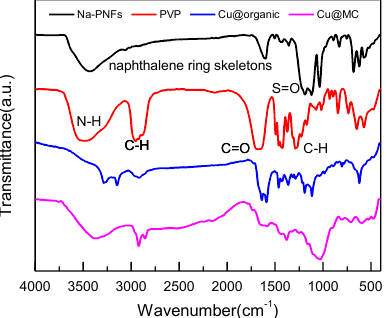
Figure 6. FT-IR spectra of Na-PNFS, PVP, Cu @organic, and